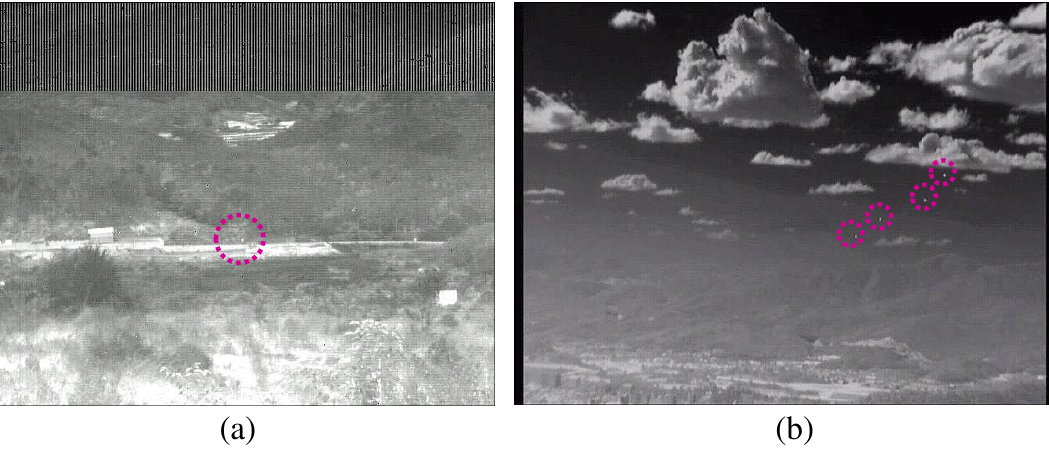
Figure 23. Real target sequence: ( a ) incoming Metis-Mmissile; ( b ) maneuvering multi targets